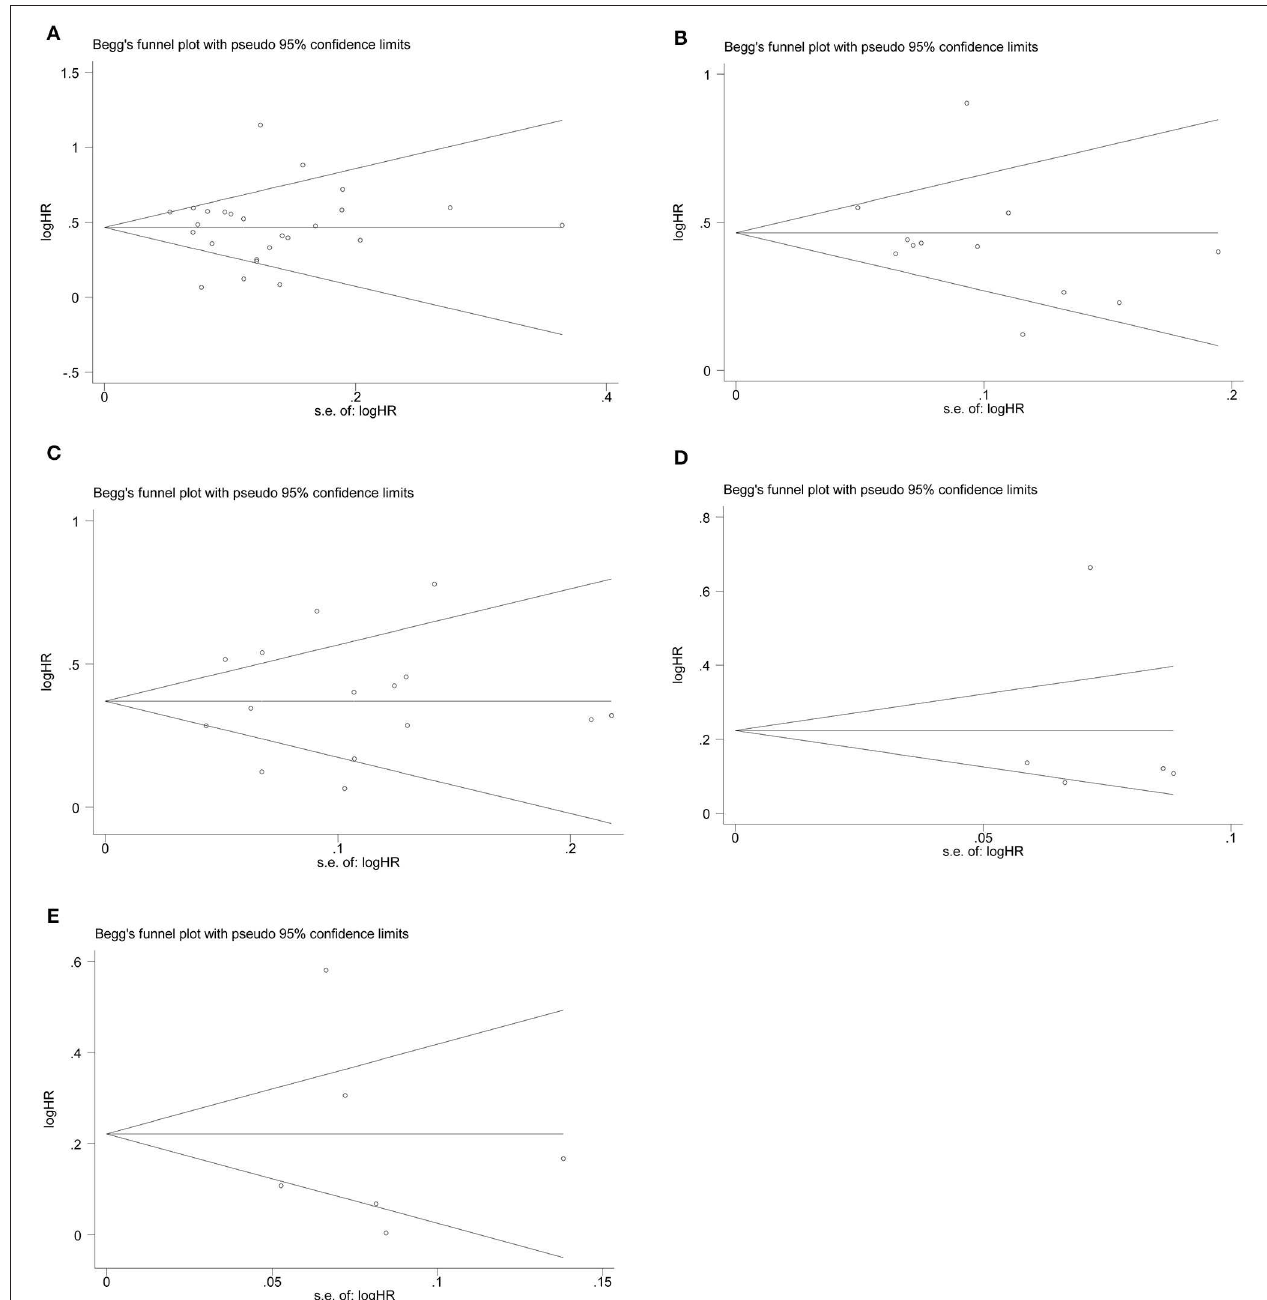
FIGURE 4 | Funnel plots evaluating possible publication bias regarding (A) CSS, (B) OS, (C) RFS, (D) CSM, and (E)